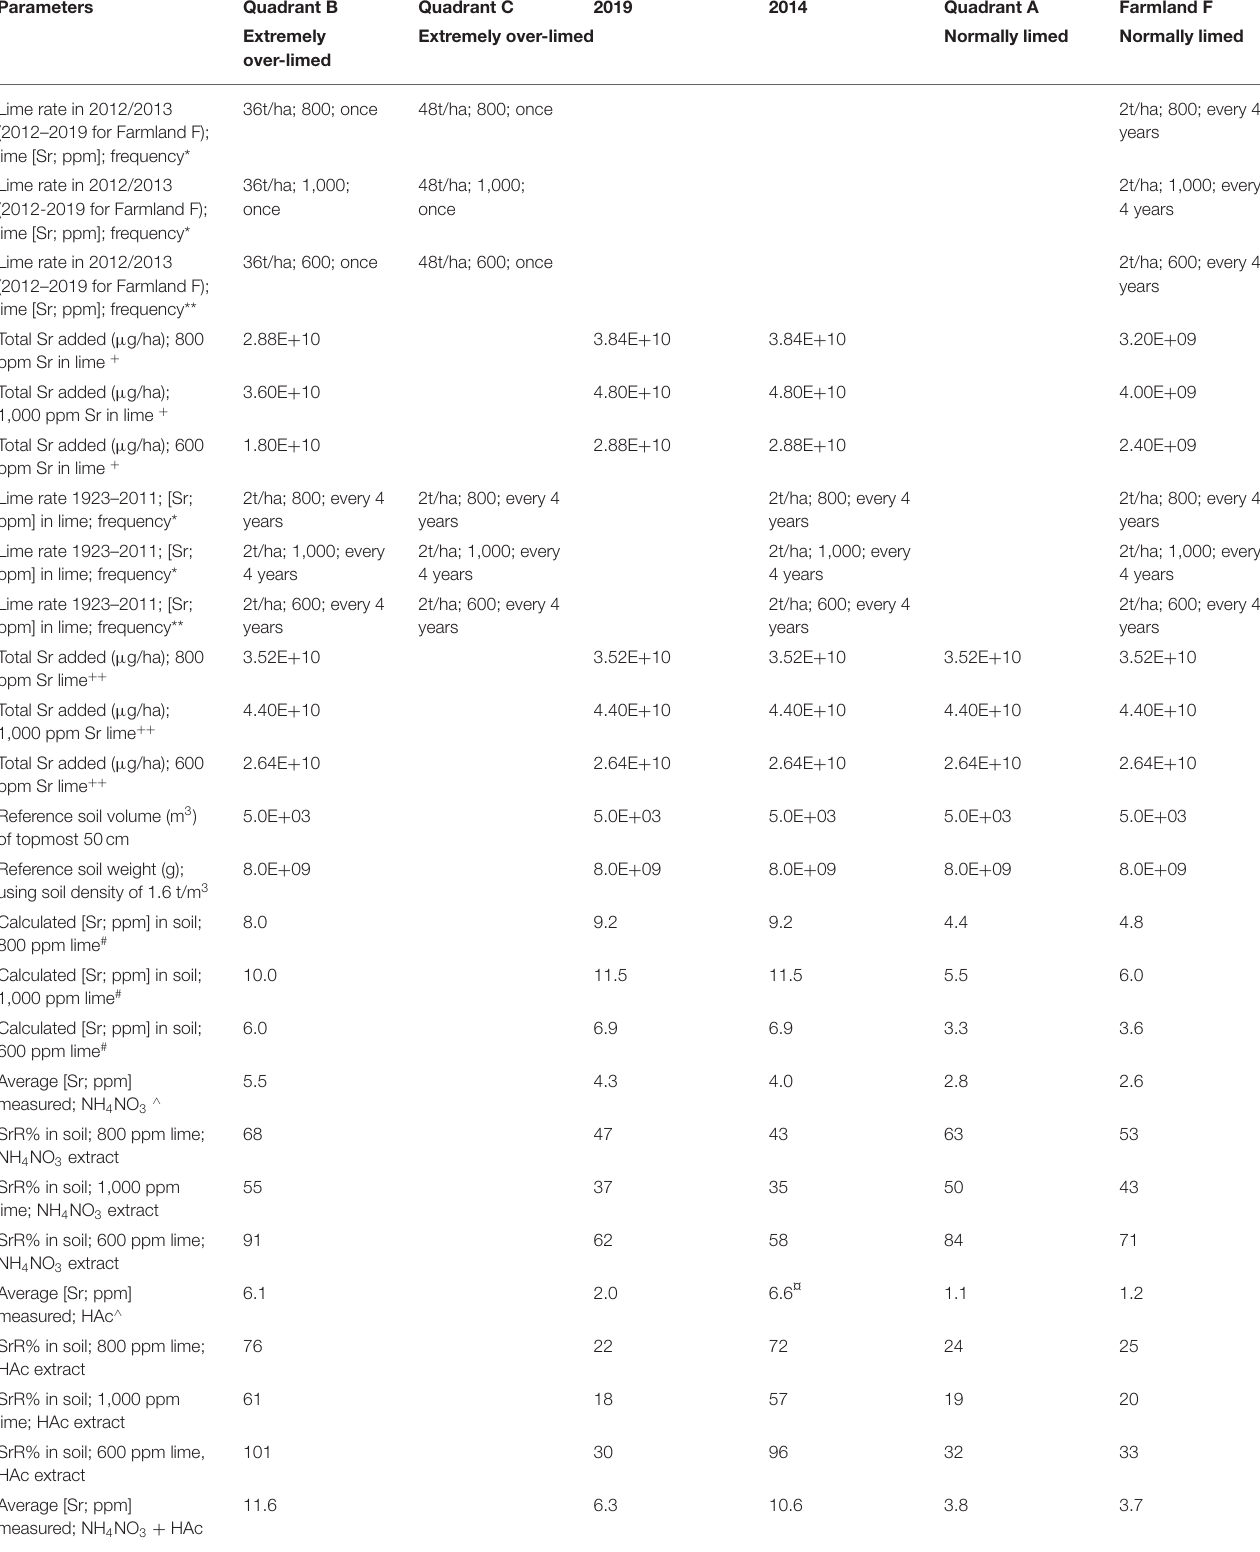
TABLE 1 | Strontium retention percentage values in 4 different profiles studied by Andreasen and Thomsen (2021). Parameters Quadrant B Quadrant C 2019 2014 Quadrant A Farmland F Extremely Extremely over-limed Normally limed Normally limed over-limed Lime rate in 2012/2013 (2012–2019 for Farmland